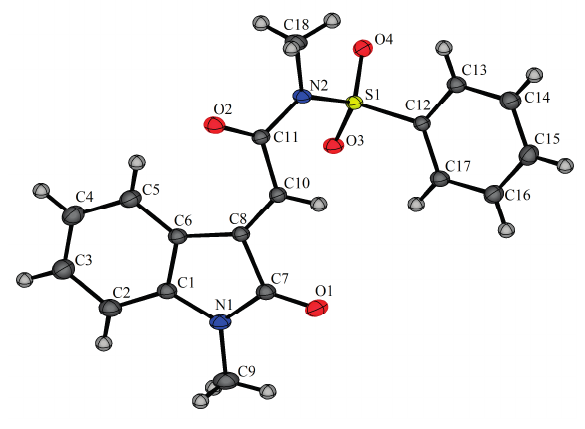
Figure 2. X-ray crystal structure of (2 E )- N -methyl-2-(1-methyl-2-oxo-1,2-dihydro-3 H